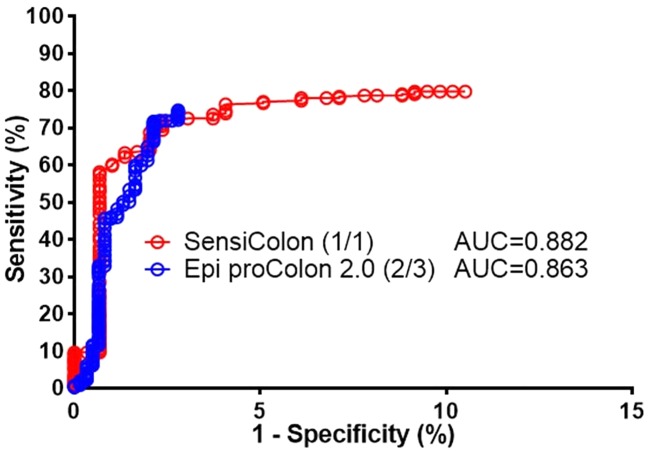
The ROC curves showed no difference in performance for the two types of SEPT9 assays.Comparison of the ROC curves was shown for Epi proColon 2.0 and SensiColon assays. 2/3 algorithm was used for data analysis in Epi proColon 2.0 CE assay, and 1/1 algorithm was used for SensiColon assay. No significant difference was found in AUC between the two assays.